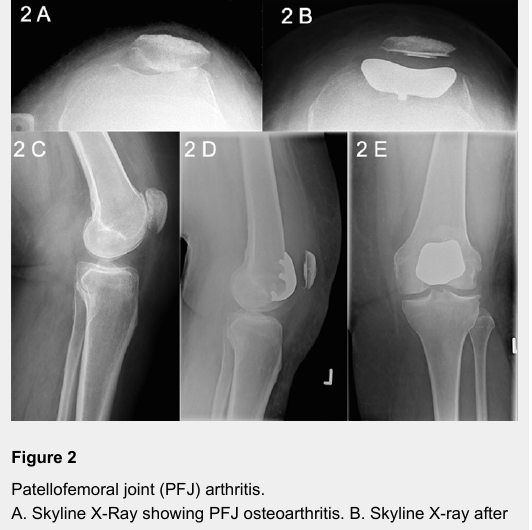
A. Long-standing X-ray showing unicompartmental medial knee osteoarthritis. B. Anteroposterior X-ray showing unicompartmental medial knee osteoarthritis. C. Postoperative anteroposterior X-ray following unicondylar knee arthroplasty (UKA). D. Lateral X-ray following